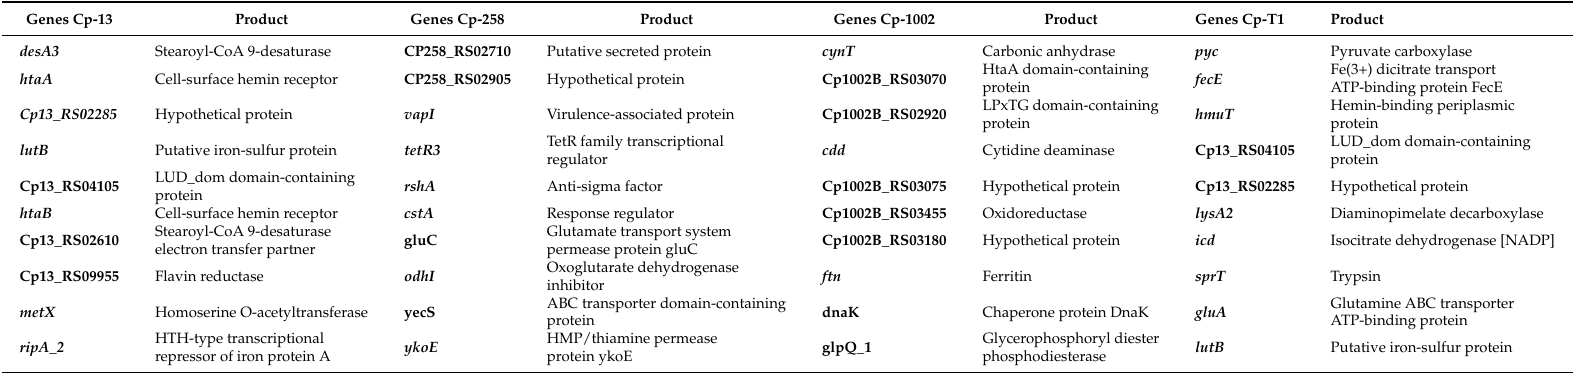
Table 5. Proteins produced by the top 10 influential genes identified in the networks built with the differentially expressed genes’ data from Cp-258 and